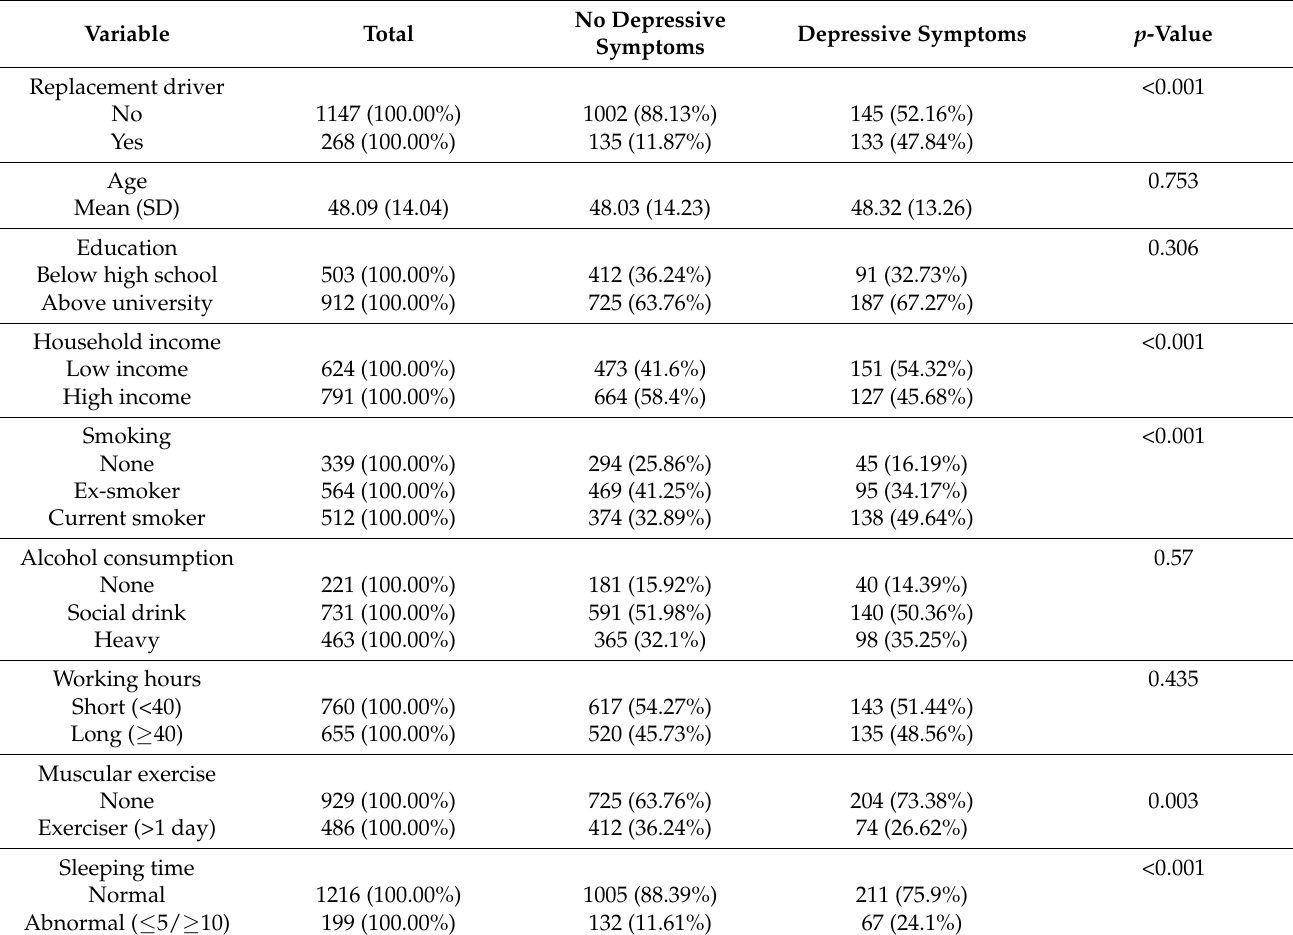
Table 2. Baseline characteristics of participants stratified by depressive